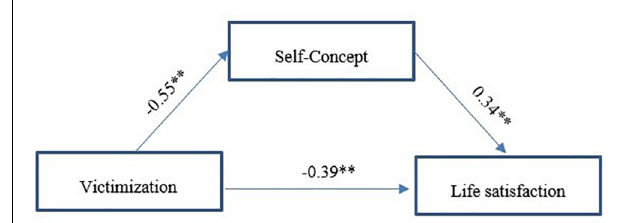
FIGURE 1 | Proposed mediation model linking victimization, self-concept, and life satisfaction. ∗∗ p < 0.01.